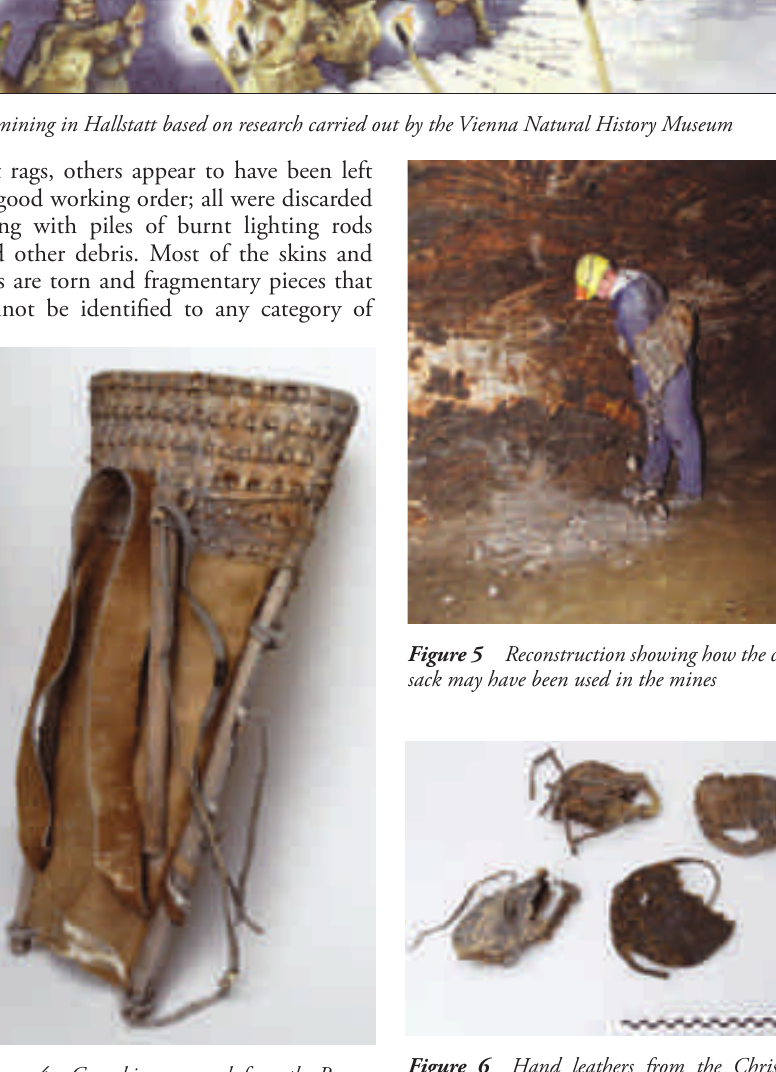
Figure 4 Cow skin carry sack from the Bronze Figure 6 Hand leathers from the Christian von Tuschwerk site